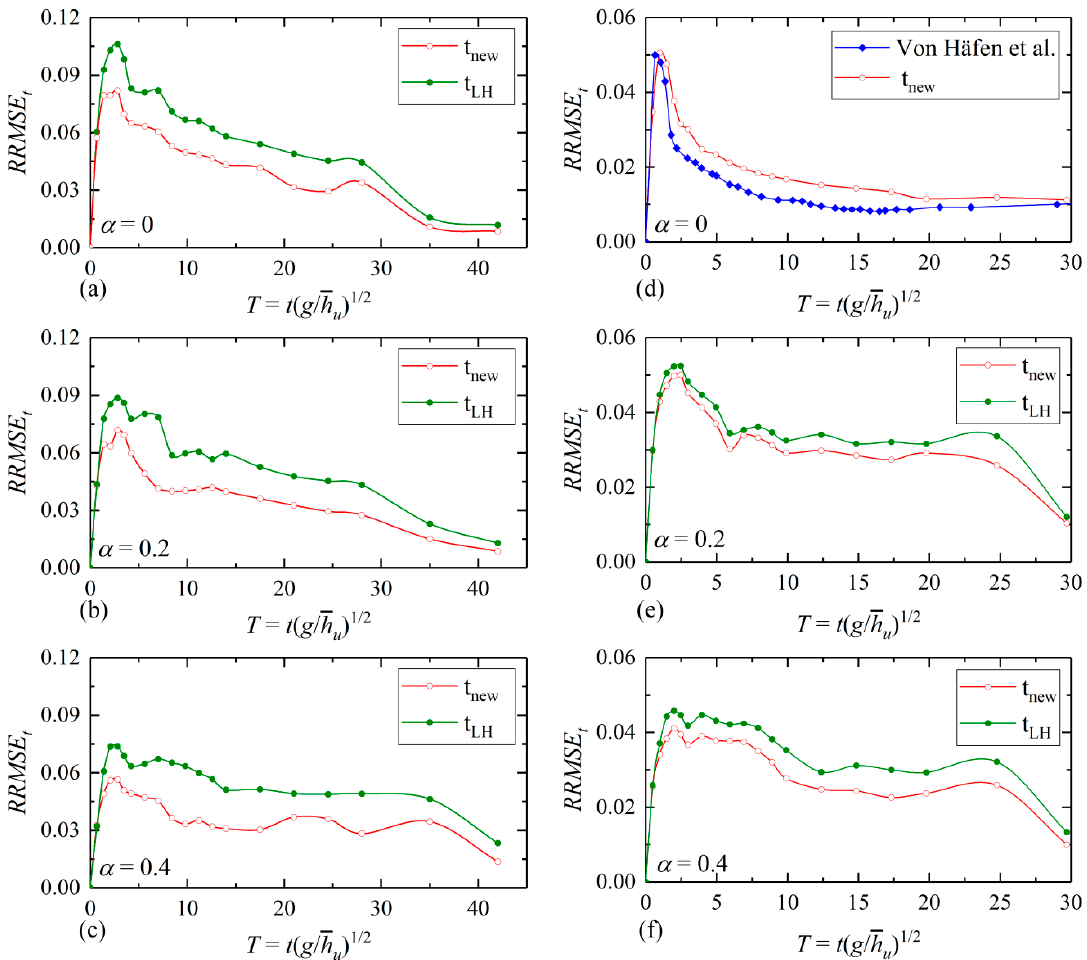
Figure 7. Variation of RRMSE t with time in a triangular channel (the left column) and rectangular channel (the right column). ( a ) α = 0 in the triangular channel; ( b ) α = 0.2 in the triangular channel; ( c ) α = 0.4 in the triangular channel; ( d ) α = 0 in the rectangular channel; ( e ) α = 0.2 in the rectangular channel; ( f ) α = 0.4 in the rectangular channel.